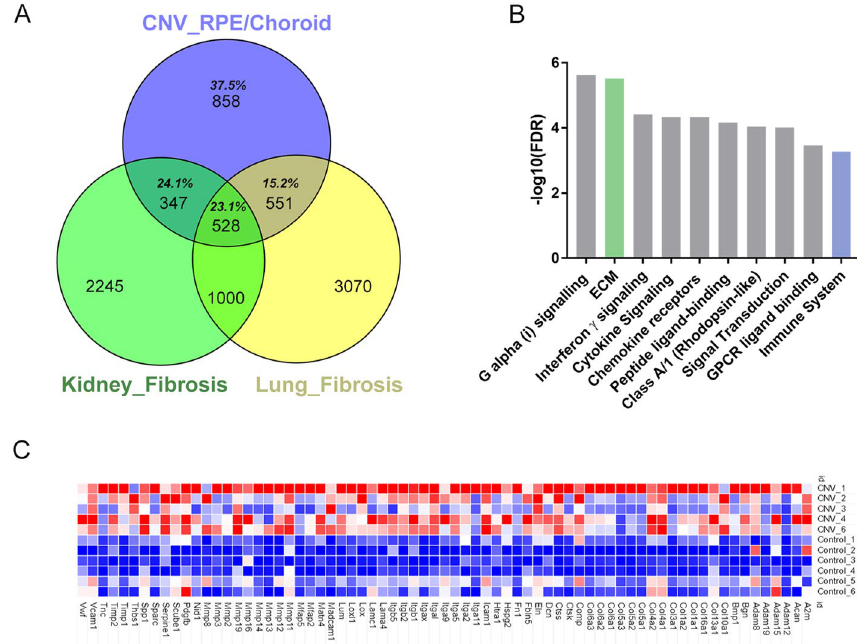
Figure 4. Overlap of DEG between CNV and other models of fibrosis and evidence of ECM gene signalling in human CNV. ( A ) Venn diagram showing that the majority of DEGs (total 62.5%) in laser CNV overlap (purple) with either kidney (teal), lung fibrosis (yellow) or both (green). ( B ) Reanalysis of human-CNV DEG genes shows that ECM pathway (green) was the second highest significant reactome compared to the other top 8 reactomes (grey) and immune system reactome (blue). x-axis is reactome pathways ranked by statistical significance (FDR) and y-axis is − log10 FDR. ( C ) A heatmap of RNAseq counts for the ECM reactome genes showing upregulation in CNV samples compared to control samples. The raw counts for each sample are shaded in pseudo colour with higher counts (red) and lower counts (blue). DEG differential expressed genes, CNV choroidal neovascularization, FDR false discovery